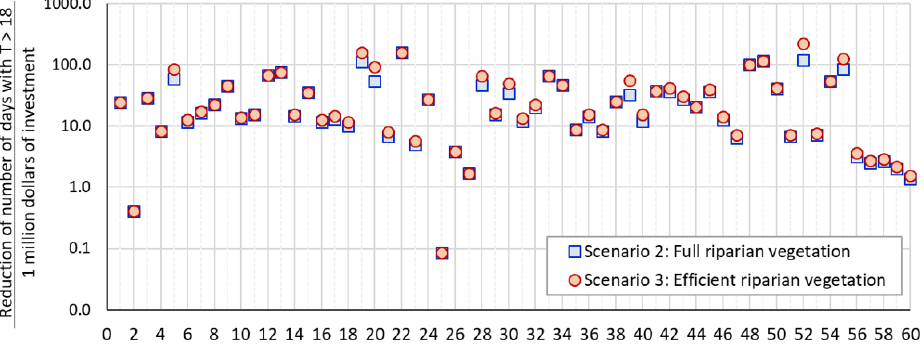
Figure 8. Benefit–cost ratio (reduction of the number of days that exceed 18 ◦ C per cost of the riparian restoration in millions of dollars) for the 60 DMW stream for the case of full riparian restoration (scenario 2) and efficient riparian restoration (scenario 3).